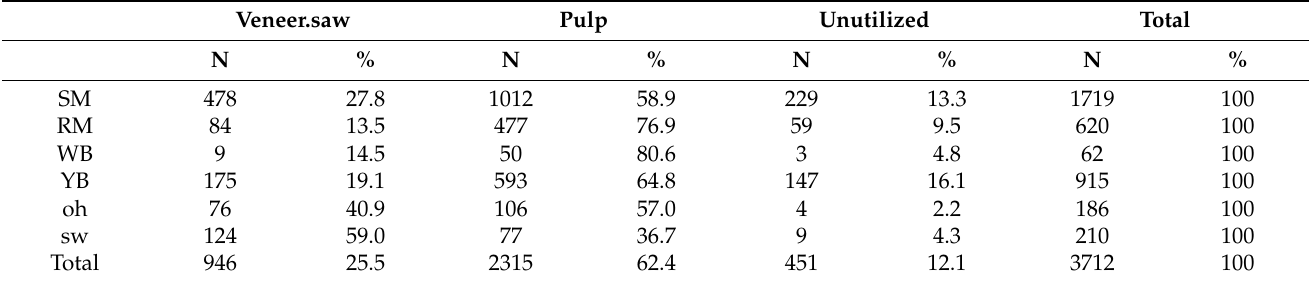
Table 6. Count and percentage of products bucked depending on species group (SM: sugar maple; RM: red maple; WB: white birch; YB: yellow birch; oh: other hardwoods; sw: softwoods) and product